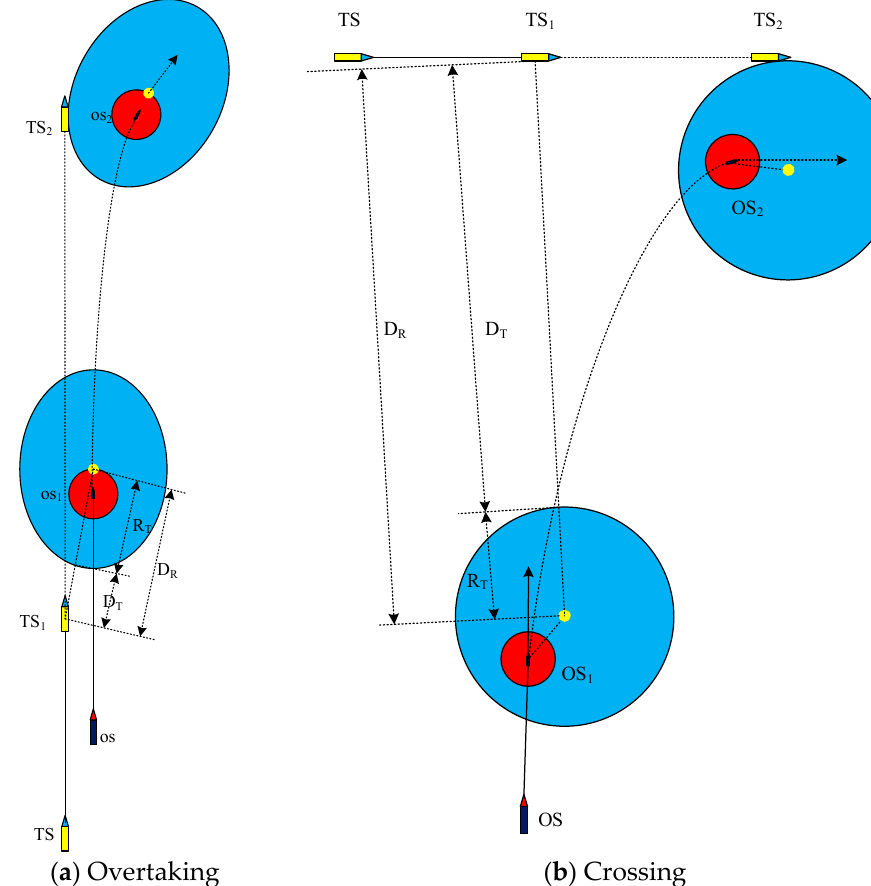
Figure 6. Collision-avoidance action by the stand-on vessel in an overtaking/crossing situation.